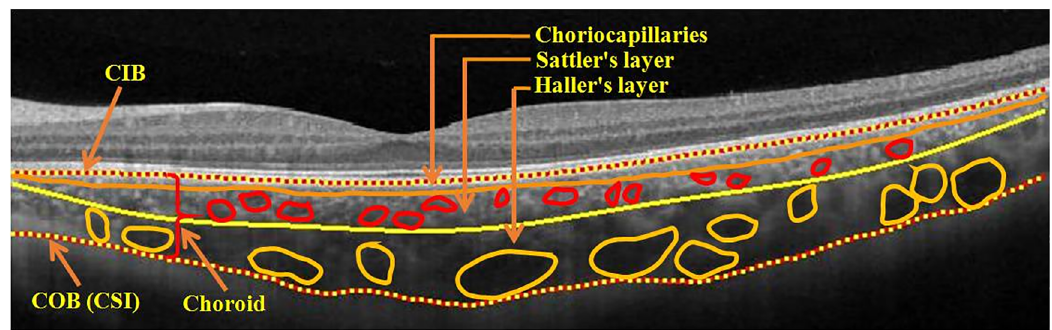
Fig 1. Sample swept-source OCT B-scan depicting the choroid layer and its sub-structures—Choriocapillaris, Sattler’s layer and Haller’s layer. Notation: CIB—Choroid inner boundary; COB—Choroid outer boundary; CSI—Choroid-sclera interface.